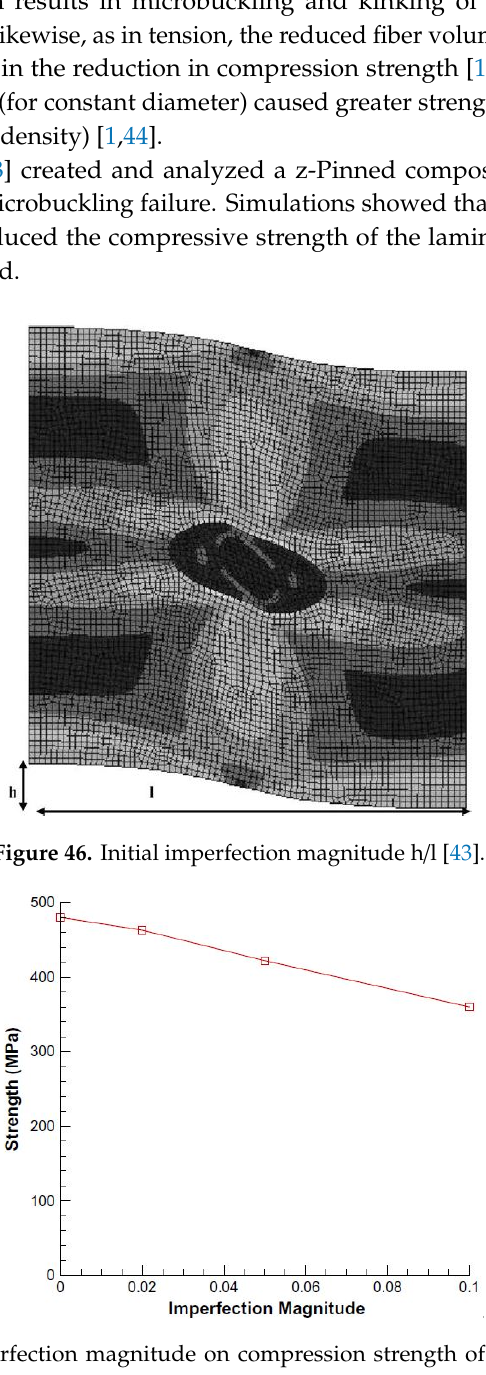
F igure 48. S-N curve for z-Pinned composite subjected to cyclic compression-compression (CFRP z-Pins, d = 0.28 mm, [0] pre-preg) [1]. The recent work of J. Hoffmann, G. Scharr [46] confirmed the above observations. They investigated the static and fatigue compression behavior of unidirectional (UD) and quasi-isotropic CFRP laminates reinforced with rectangular and circular z-Pins. The use of z-Pins did not alter the compression modulus of the tested coupons. In contrast to this finding, all z-pinned laminates demonstrated an important reduction in compressive strength compared to unpinned samples. Furthermore, the use of rectangular shaped z-Pins led to less reduction in the compression strength in both CFRP laminates (UD and quasi-isotropic). Under fatigue loading, the insertion of both rectangular and circular z-Pins resulted in the decrease in the fatigue performance of both UD and quasi-isotropic laminates.